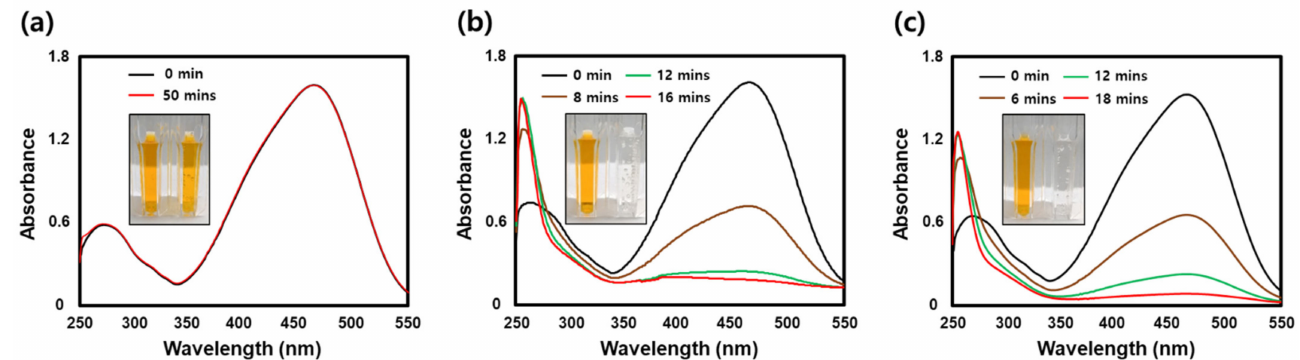
Figure 11. UV–Vis spectra of methyl orange (MO) dye reduction in the presence of different catalysts, ( a ) NaBH 4 , ( b ) SS-AgNPs, and ( c ) SS-AuNPs.